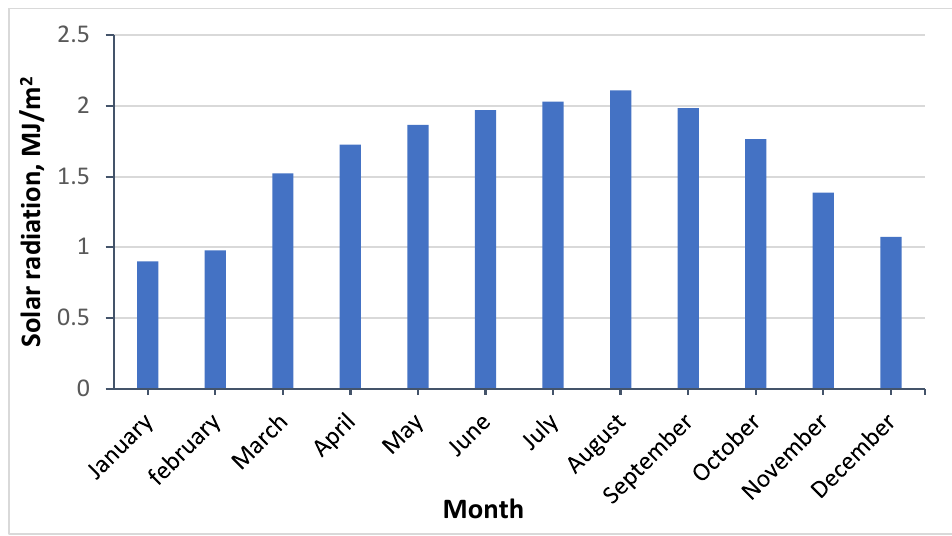
Figure 4. Measured monthly radiation data.